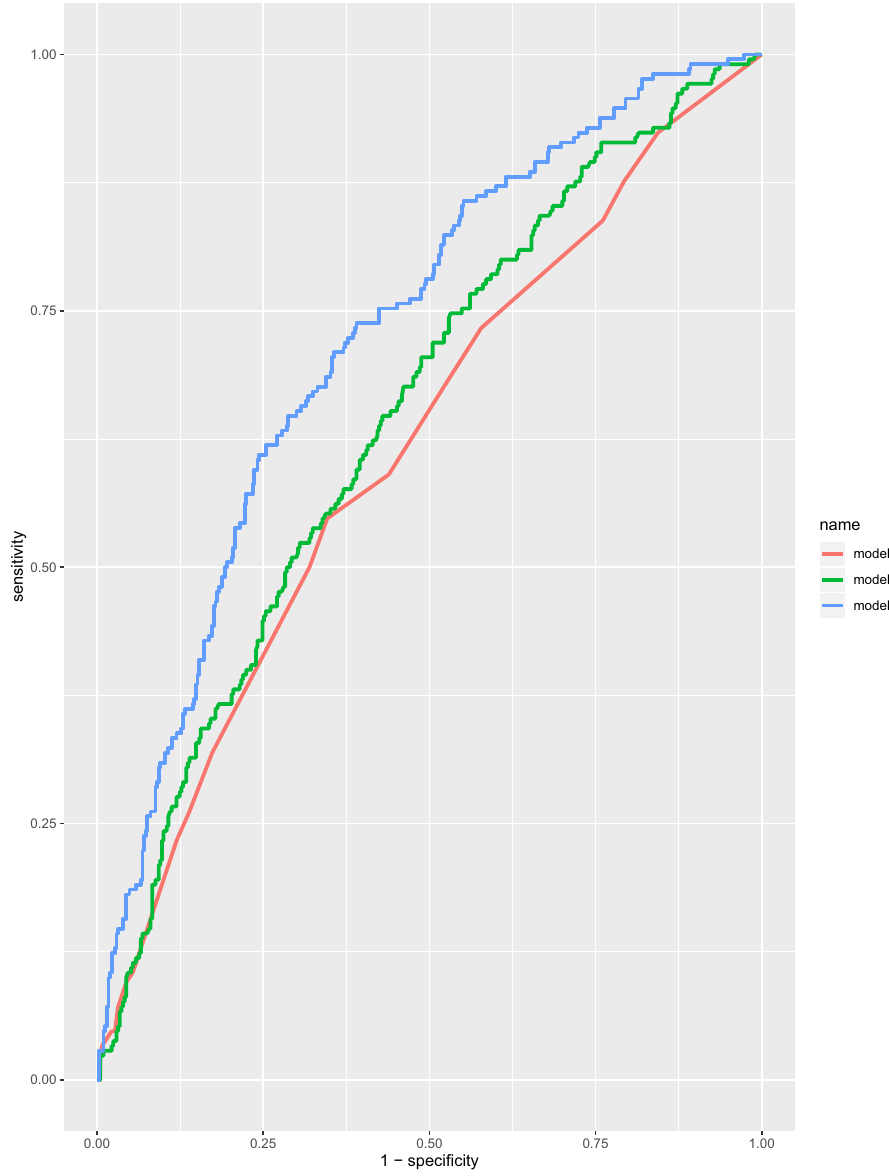
Figure 1. Comparisons of receiver operating characteristic curves. Model 1, (M1) Morse Fall Scale (MFS); Model 2, (M2) MFS, age, sex, ward, and polypharmacy; Model 3, (M3) MFS, age, sex, ward, polypharmacy, diabetes mellitus, cognitive impairment, leukocytosis, hypoalbuminemia, hyponatremia, calcium channel blockers, diuretics (thiazides or spironolactone), antipsychotics, anticonvulsants, benzodiazepines, and